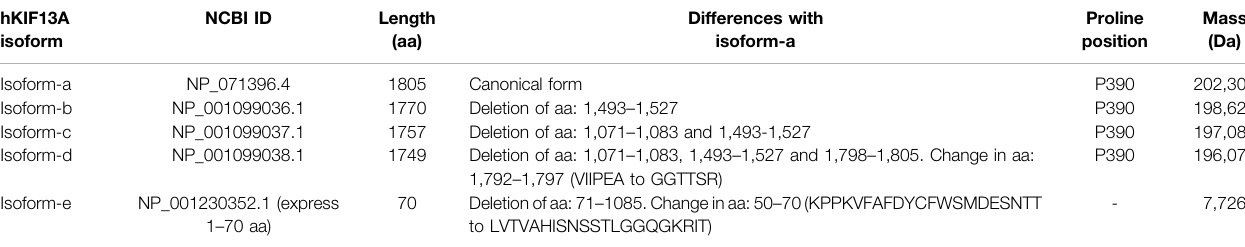
TABLE 1 | List of KIF13A isoforms from human. hKIF13A isoform